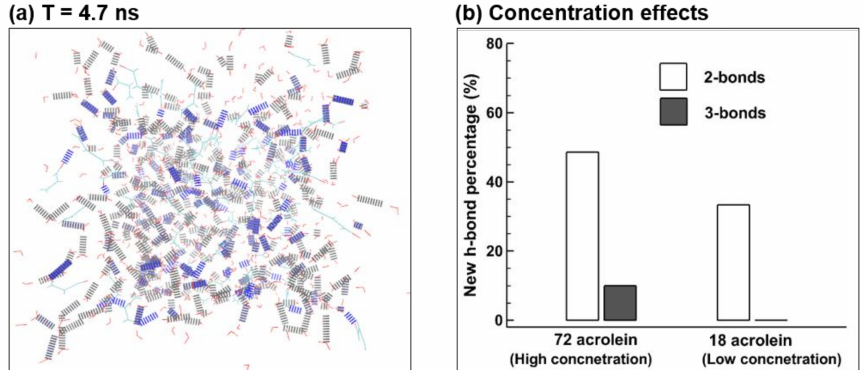
Figure 10. Concentration effects: ( a ) Hydrogen bonds at T = 4.7 ns and ( b ) percentage of new hydrogen bonds in two different acrolein concentrations. Color scheme: hydrogen in white, oxygen in red, carbon in cyan, blue for hydrogen bonds between waters and acrolein, and grey for hydrogen bonds between water